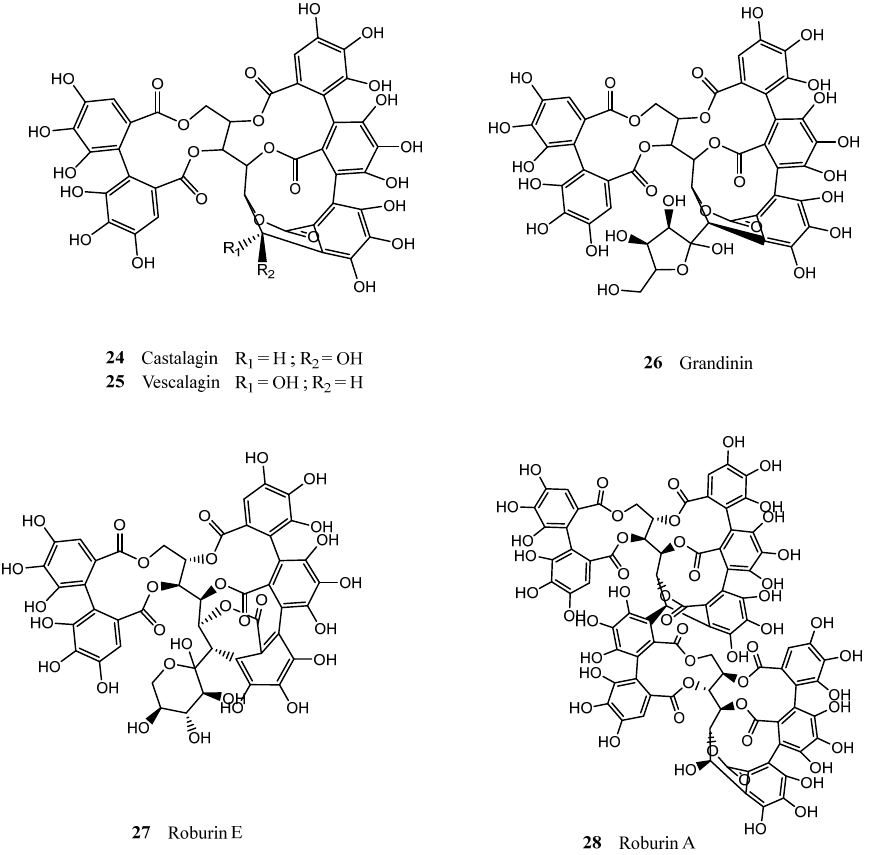
Figure 5. Chemical structures of the main tannins present in cork.